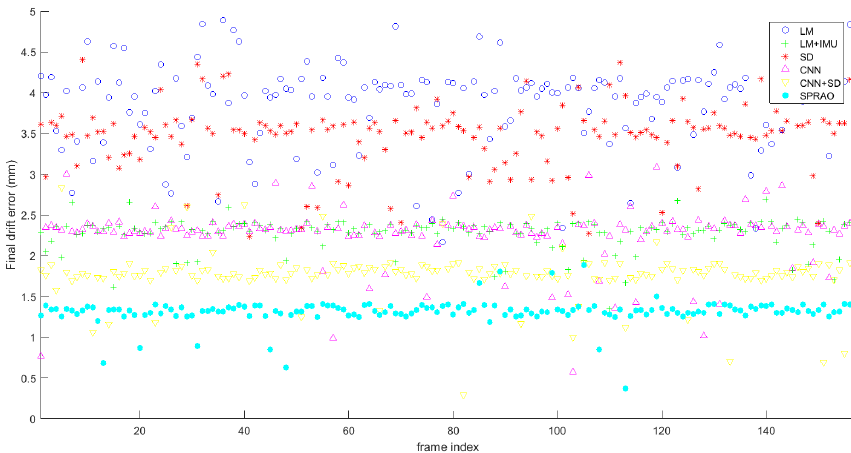
Figure 25. Reconstruction results of dataset DB3.